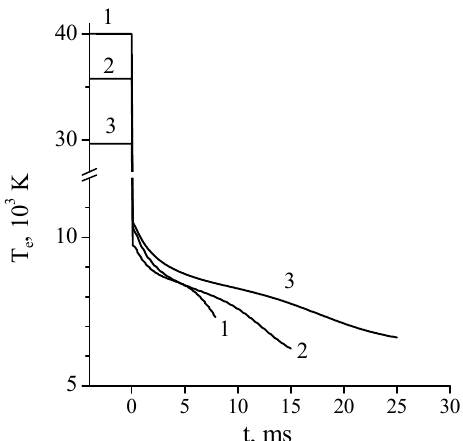
Figure 6. Calculated effective electron temperature in a dc discharge in the Ar + 1%N 2 mixture ( t < 0) and its time evolution in the discharge afterglow ( t > 0). R = 1.4 cm, I = 20 mA. P = 1 Torr (1), 2 Torr (2), and 5 Torr (3) [26].